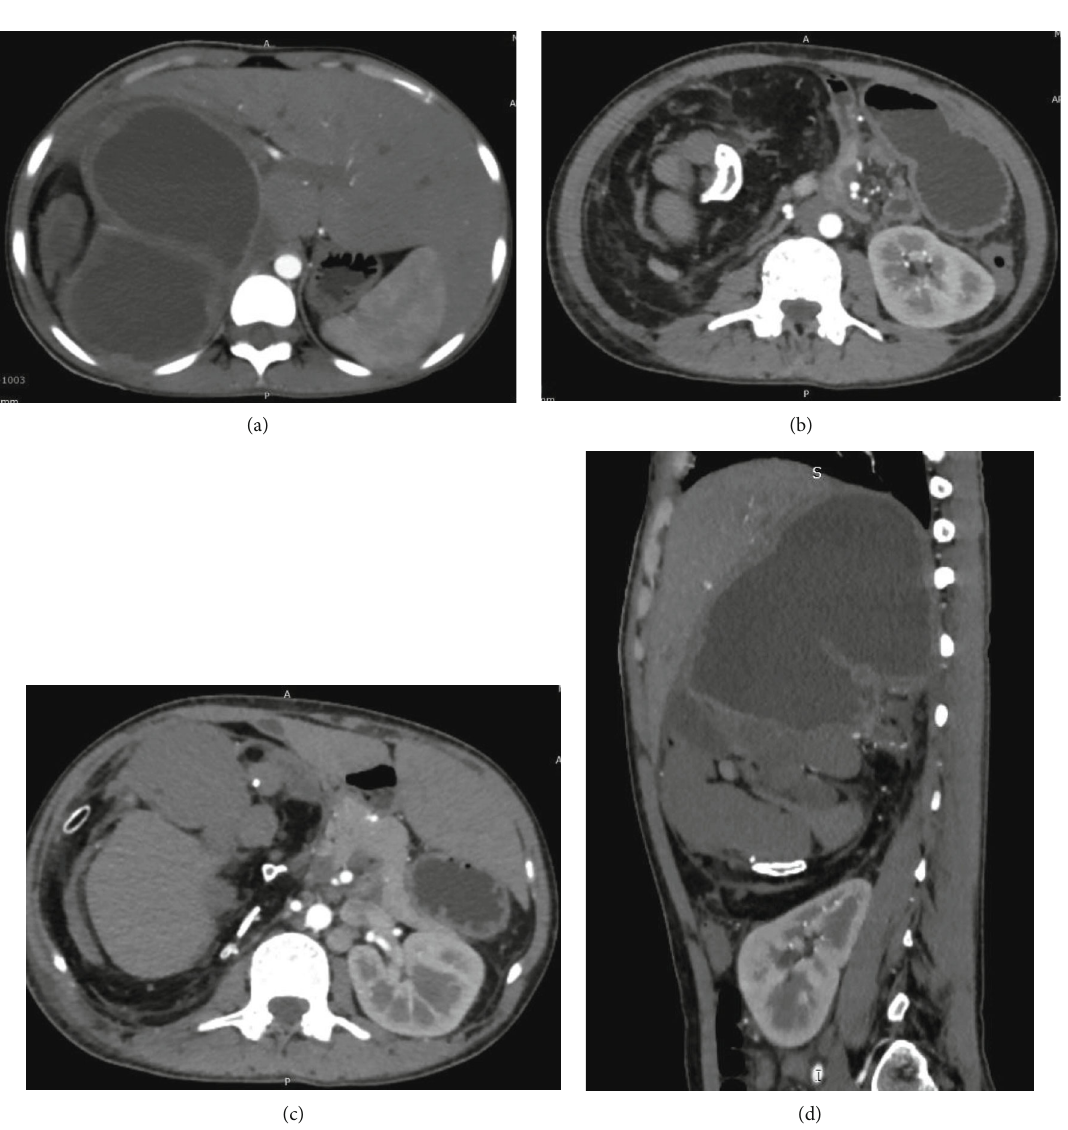
Figure 1: Abdominal computed tomography shows a large heterogeneous retroperitoneal mass with cystic, calci fi ed, soft tissue and lipomatous components (a). Large cystic component (b). Well-formed vertebral body with surrounding lipomatous tissue (c). Well- formed ribs and long bone (d). Inferior displacement of the right kidney by